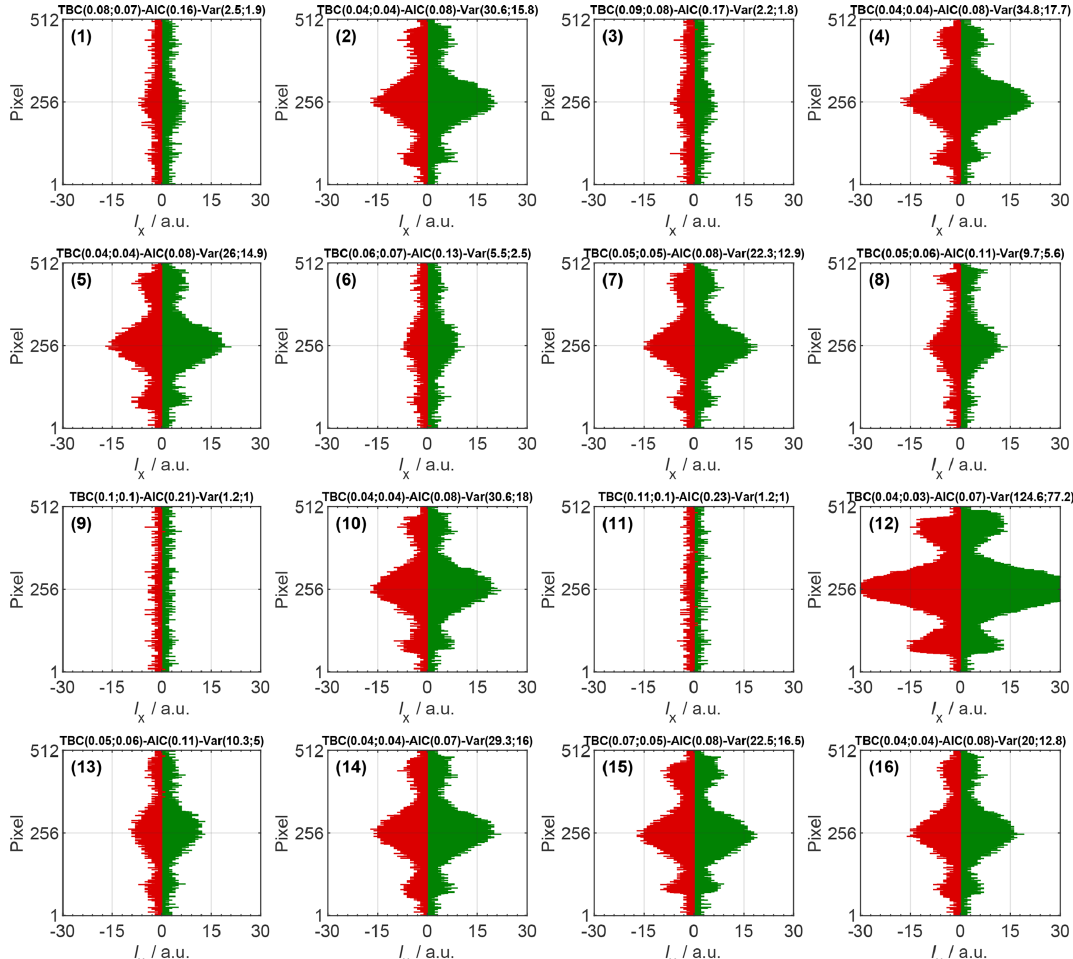
Figure B1. Example scattering patterns showing the relative scattered light intensity as a function of array pixel number for array 1 (green) and array 2 (red). Data are background-corrected and correspond to VOAG-generated PEG particles of d a , g = 3 . 39µm. The values on top of each panel depict the TBC, AIC and variance, where the first number corresponds to array 1 and the second number to array 2.